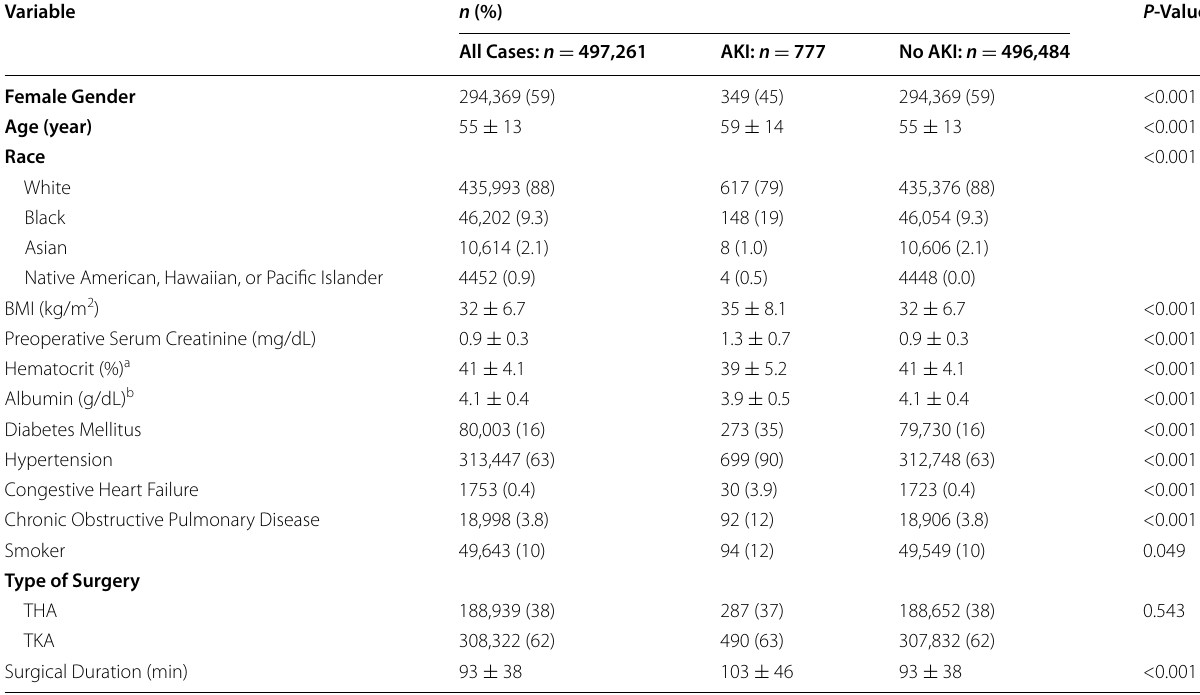
Data are expressed as number of patients (%) or mean a Values available for 489,607 total cases b Values available for 301,393 total cases